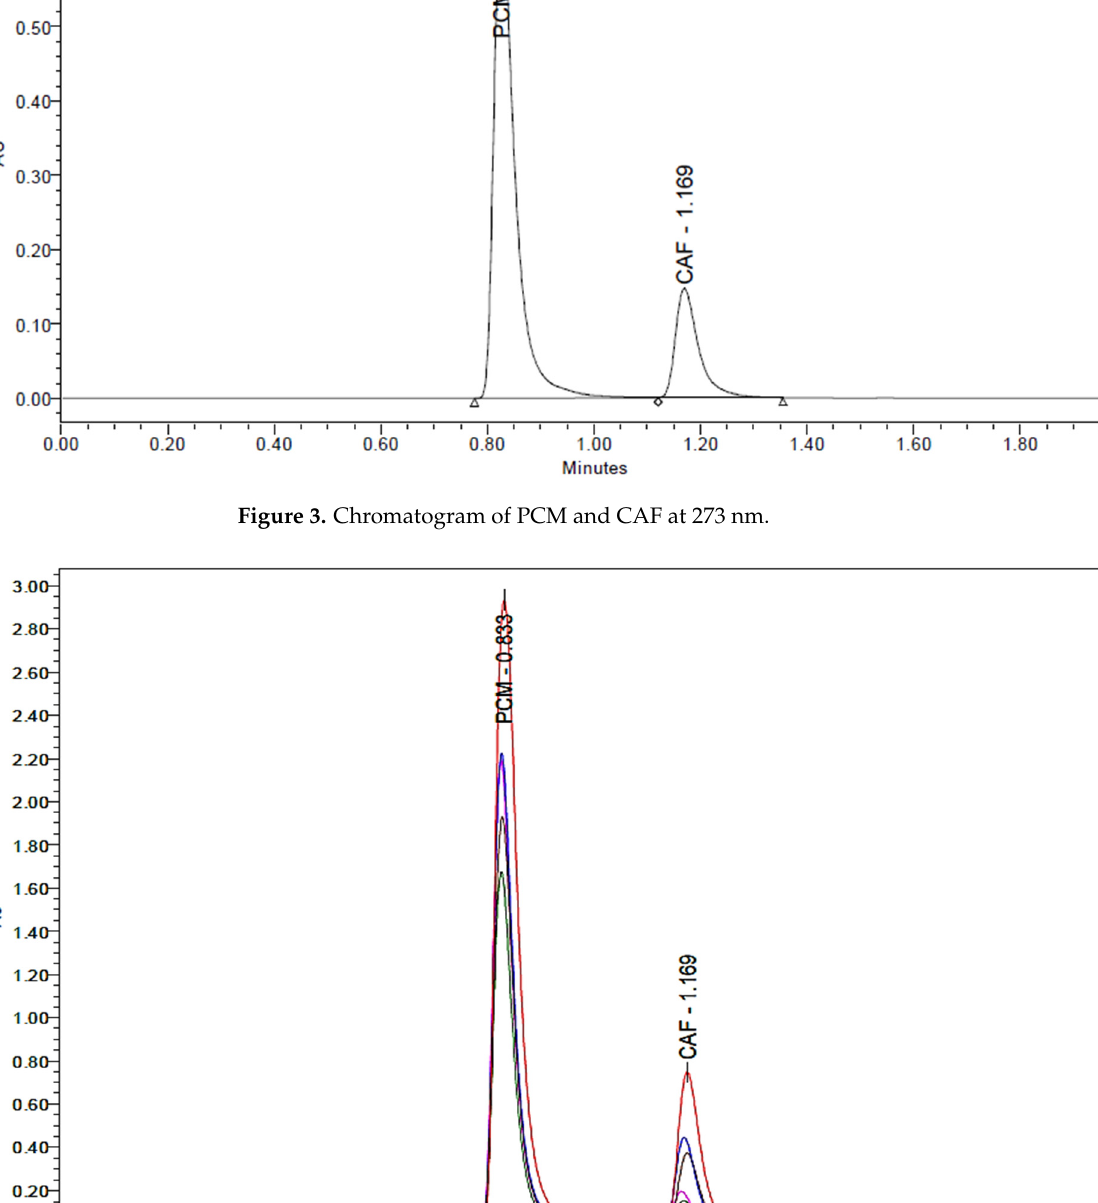
Figure 4. Overlay chromatogram of standard PCM and CAF of different levels.